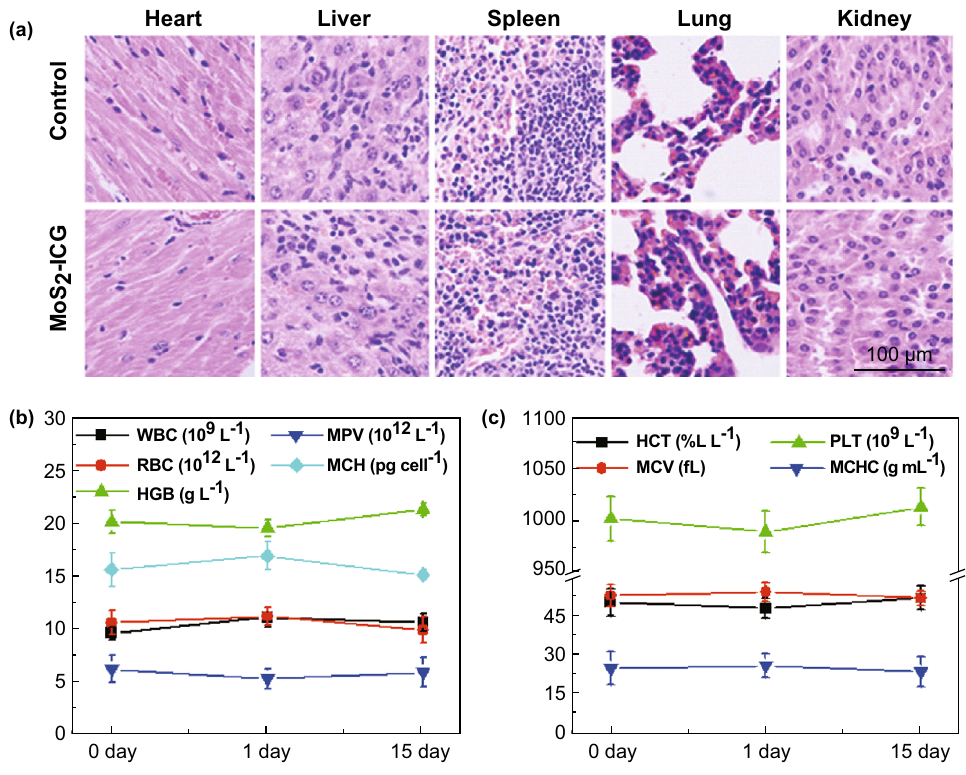
Fig. 6 a Representative H&E-stained images of the major organs including the heart, liver, spleen, lung, and kidney collected from control group mice and mice treated with MoS 2 –ICG. b , c Blood analysis of MoS 2 –ICG-treated group mice. WBC number of white blood cells; RBC number of red blood cells; MPV mean platelet volume; MCH mean corpuscular hemoglobin; HGB concentration of hemoglobin; HCT hematocrit; MCV mean corpuscular volume; MCHC mean corpuscular hemoglobin concentration; PLT